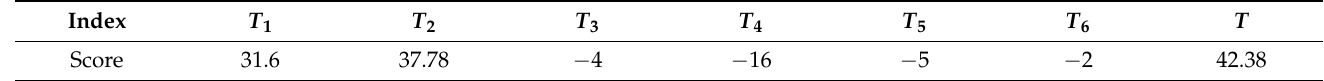
Table 15. Middle rock pillar